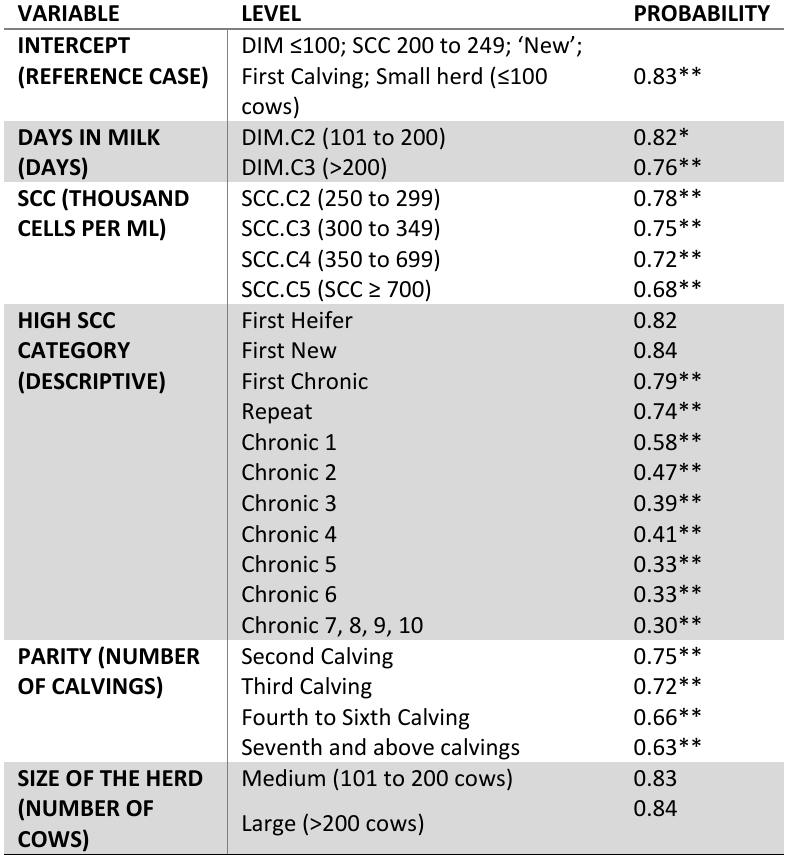
Table 4: Estimates of recovery probability for each level of the different variables